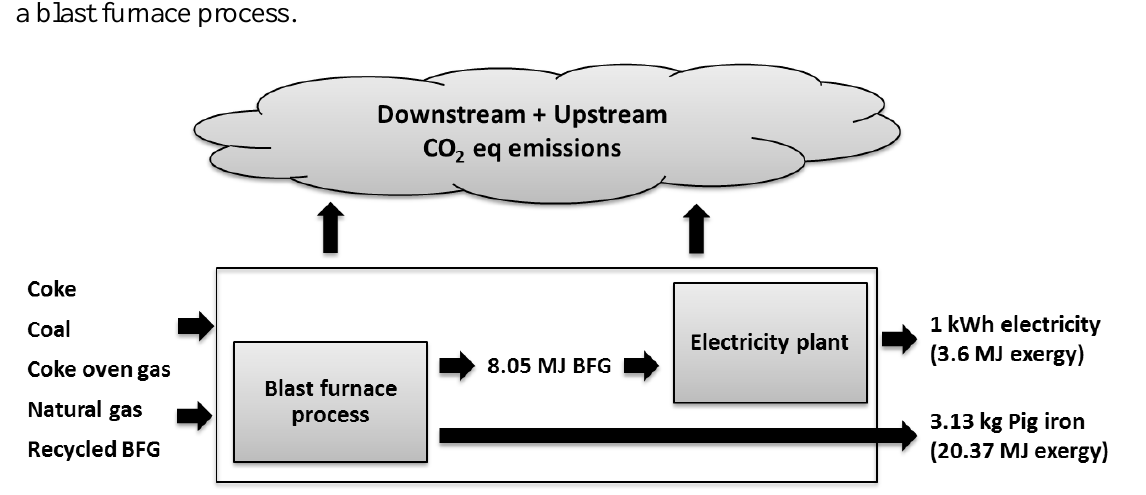
Figure 4. Overview of the exergetic allocation rule for pig iron and electricity produced in a blast furnace